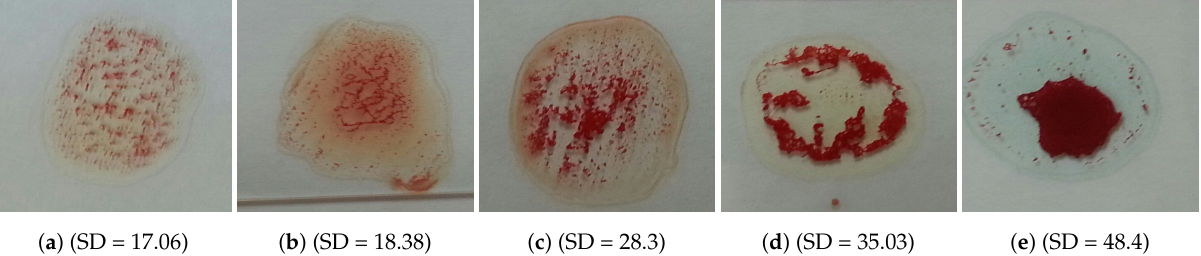
Figure 3. Blood samples with agglutination and their standard deviation values